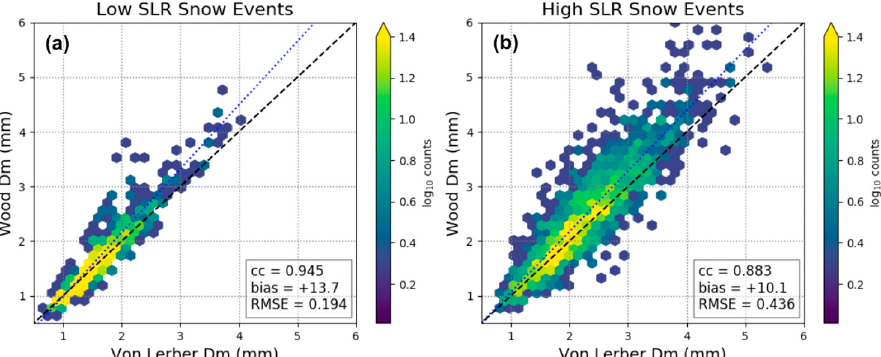
Figure 4. Shown are comparisons of calculated mass-weighted diameter ( D m ) from the von Lerber and Wood retrievals for the low SLR ( a ) and high SLR ( b ) snow events. The von Lerber D m is plotted on the x-axes and the Wood D m on the y-axes. The black dashed line represents a 1:1 relationship, while the blue dotted line is the linear regression fit to the data.